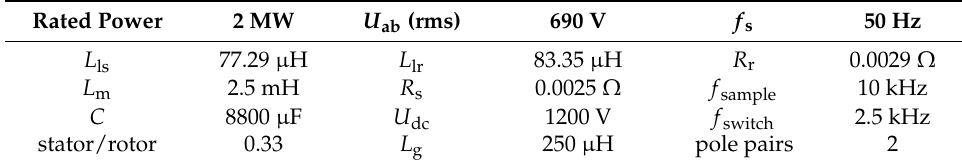
Figure 1. The grid impedance in the model is L grid = 0.004 H, which is related to the short-circuit ratio of power system. The distorted grid voltage of the following figs all contains 5% 5th harmonics and 5% 7th harmonics. Table 1. Parameters of The Simulation Table 1. Parameters of The Simulation Model. Table 1. Parameters of The Simulation Model.